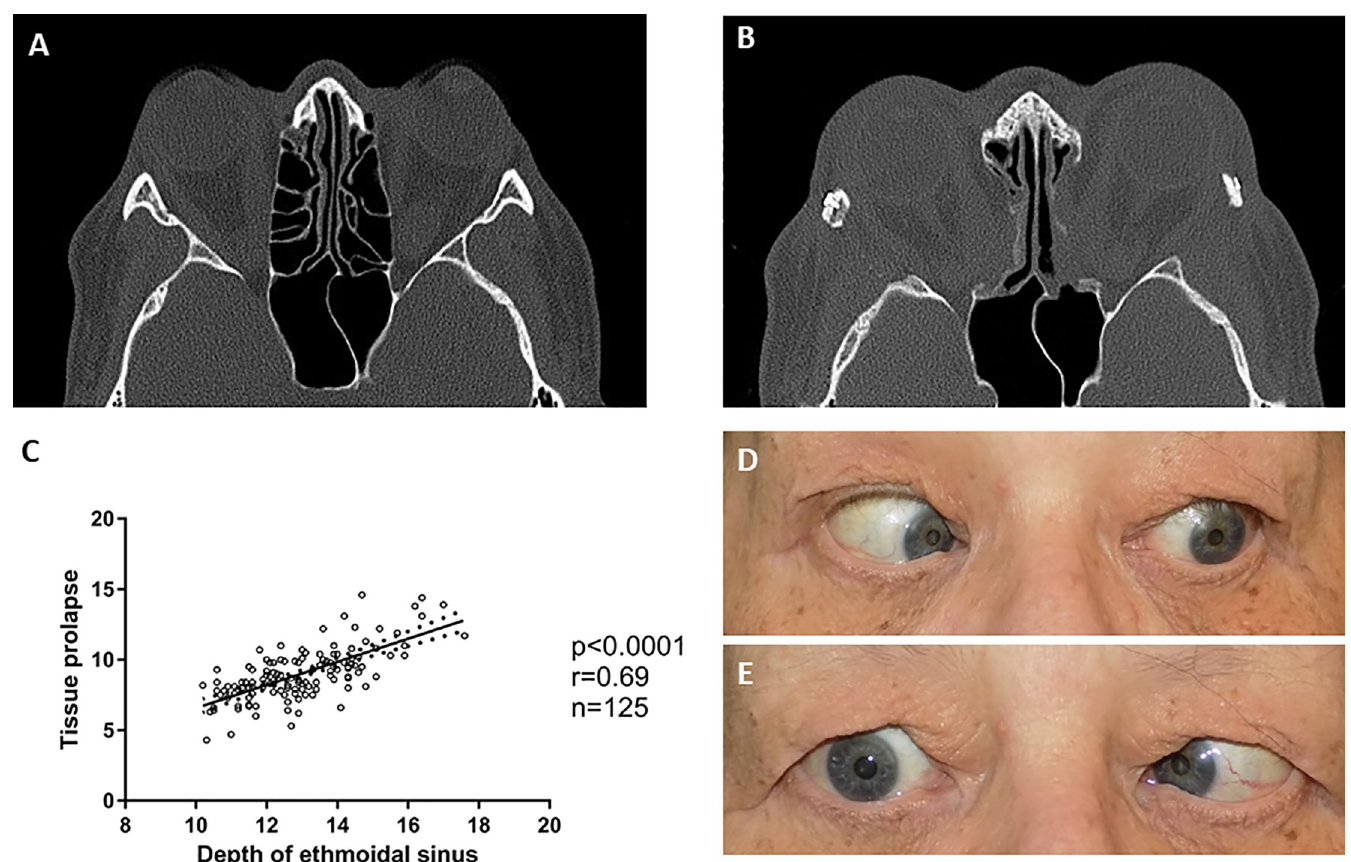
Fig 3. Preoperative CT scan of a patient with a deep ethmoidal cavity, with a high amount of tissue prolapse postoperatively (A-B) Linear regression showed a significant correlation between postoperative abduction deficit and tissue prolapse (C) , as exemplary shown in this postoperative images during left and right gaze (D-E) . Linear regressions were performed to predict proptosis reduction: The decrease of proptosis correlated significantly with conus angle (p = 0.03, r = 0.22), but not significantly with tissue prolapse, defect length, depth of ethmoidal sinus and the muscle diameter. Postoperative abduction deficit correlated significantly with the amount of tissue prolapse (p < 0.01, r = 0.25) and orbital surface area (p = 0.01, r = 0.22). A multiple linear regression showed an even better correlation for both parameter combined (F(2,122) = 9,7; p < 0.0001, r = 0.37). The maximum horizontal muscle diameter of SMG, IR and LR showed no significant correlation to the corresponding motility of the muscle. Adduction showed a significant correlation to the MR diameter (p < 0.001, r = 0.10). Furthermore, a multiple regression was run to predict tissue prolapse from depth of the ethmoidal sinus and age (see Fig 3). These variables statistically significant predicted tissue prolapse, F (2,65) = 32.2, p <